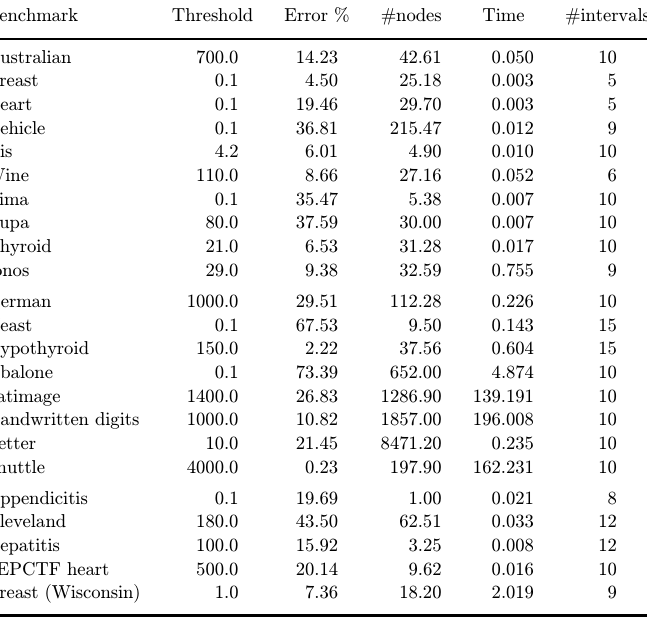
Table 4. Numerical results of ULR-Discr using the Manhattan